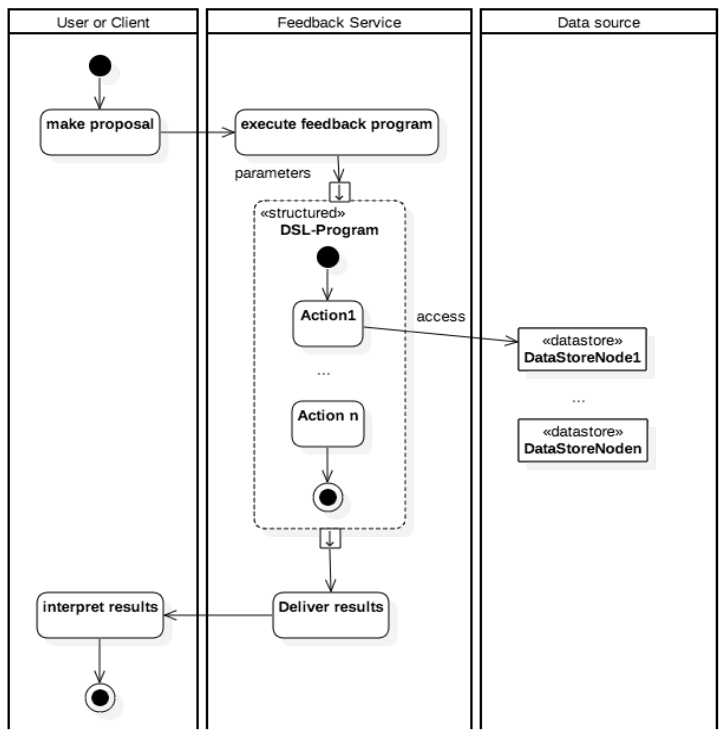
Figure 8. Generic operation of Feedback Service framework.